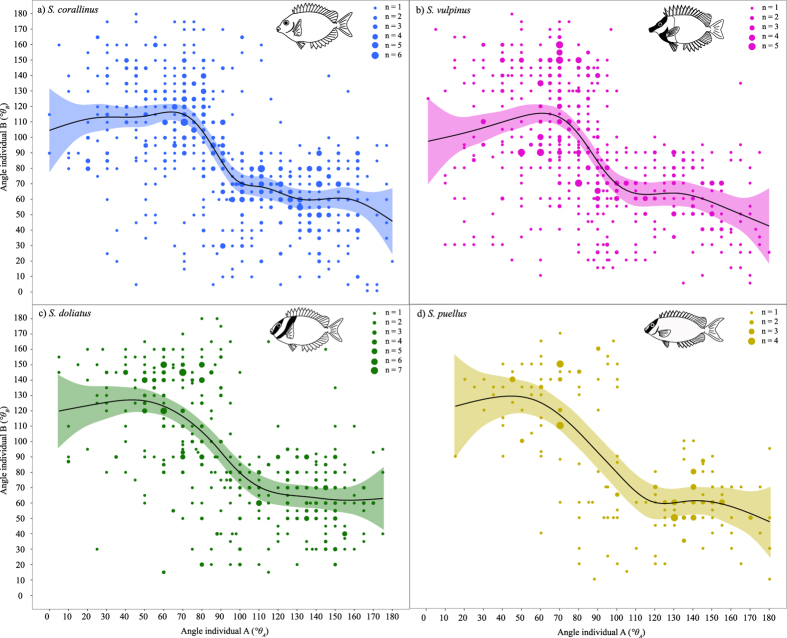
Graphical representation of coordination between foraging and vigilance in four species of rabbitfish pairs.Axes mark the angles of individuals in pairs (θA, θB), while each point represents the angle assumed at a given 5-second point intercept with the size varying according to the number of overlying points. The four predicted smoothed lines mark the predicted fits from generalized additive mixed effects models (GAMMs) and their upper and lower 95% confidence interval. In all species, data are predominantly spread between the upper left and lower right quartile of the plot. The smoothing function, fit by automatic cross-validation, suggests that individuals assume contrasting angles (<90° and >90°); however, the extent of the angle is negligible once a certain threshold is reached (~120° and 60°, respectively). The observed pattern was consistent among species. (a) S. corallinus (n = 15), (b) S. vulpinus (n = 15), (c) S. doliatus (n = 15), (d) S. puellus (n = 14). n = number of independent pairs represented in the plot. Fish illustrations are original drawings by Simon J. Brandl.